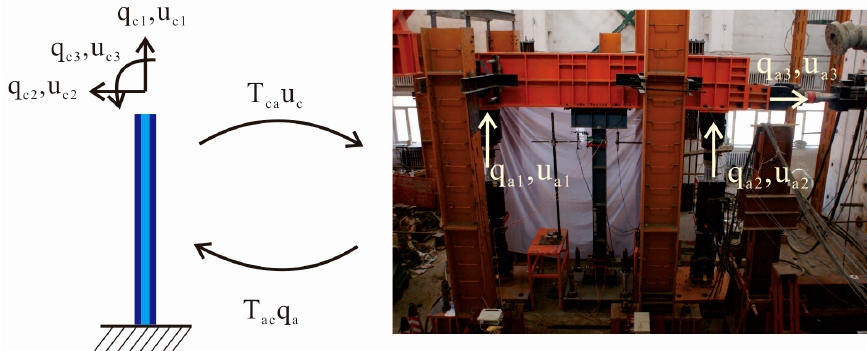
Figure 4. The coordinate transformation between specimen and three actuators.